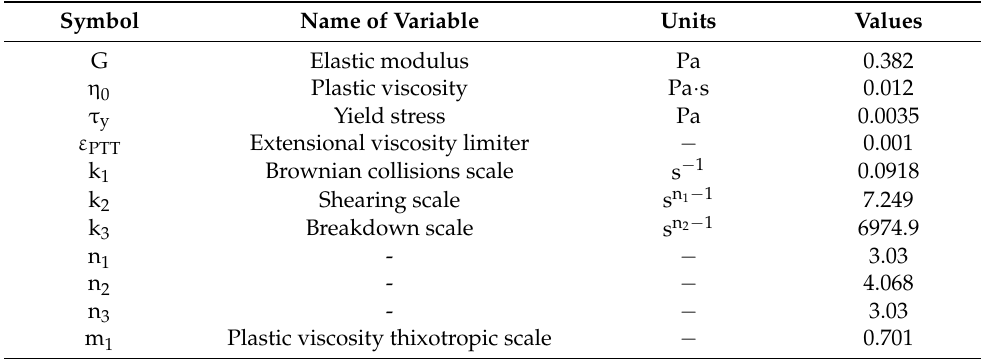
Table 1. Fitted rheological parameters of the TEVP model on steady and transient experimental hemorheological data reported in [55].